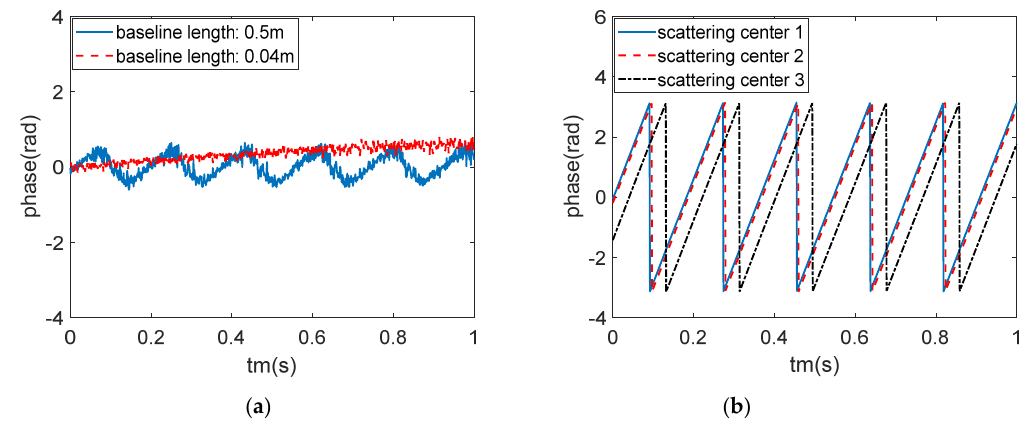
Figure 6. Phase difference curves of spatial spectrums. ( a ) Conventional method. ( b ) Our method.